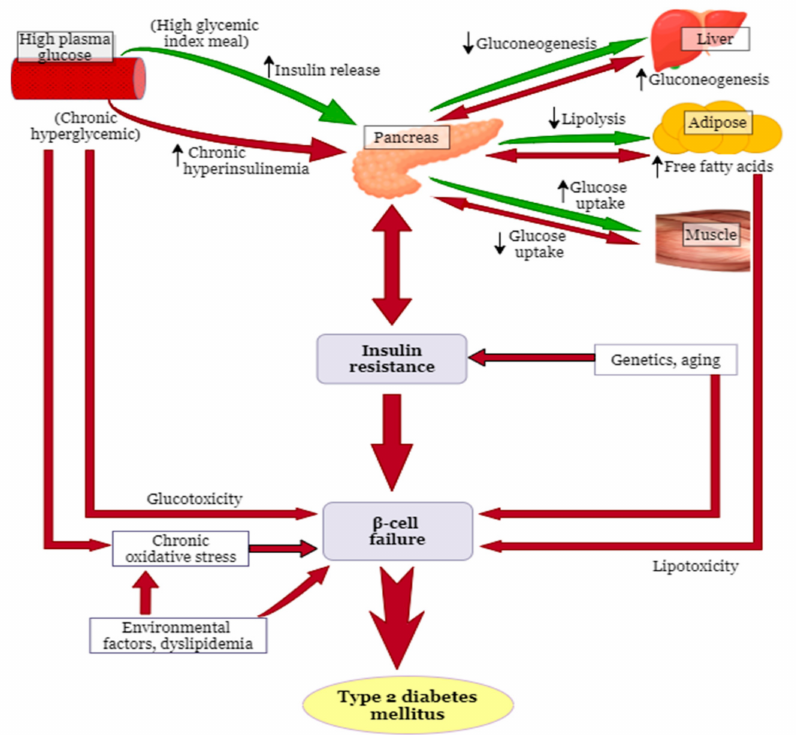
Figure 1. Normal glucose homeostasis and the pathogenesis of type 2 diabetes mellitus. This was modified, according to Ludwig [16]. The green arrows show normal glucose homeostasis, while the red arrows show the pathogenesis of type 2 diabetes mellitus. The black upward arrows represent an increase, while the downward ones represent inhibition. High plasma glucose may result from a high glycemic meal, or it may be during chronic hyperglycemia, leading to increased insulin production or chronic hyperinsulinemia, respectively. The events that follow are shown by the green and red arrows, respectively. The figure was drawn via https://app.diagrams.net/, and the pancreas, liver, and muscle pictures were obtained from